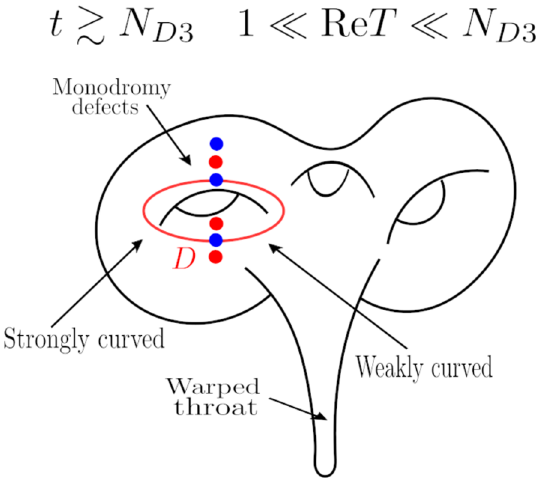
Figure 19 . Same CY as in figure 17, for intermediate overall volume t & N D 3 and 1 (cid:28) Re T (cid:28) N D 3 . The non-perturbative splitting of seven-branes has eaten up an O (1) fraction of the bulk CY but leaves enough room for a large physical volume of the divisor D , i.e. Vol ( D ) ∼ log( | W 0 | − 1 ) (cid:29) 1